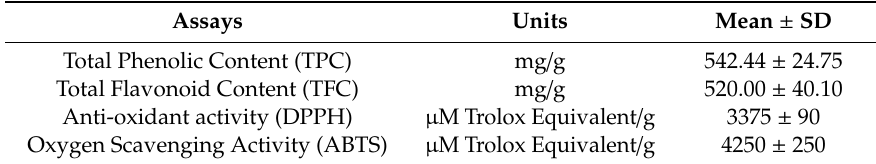
Table 2. Characterization of anti-oxidation properties of